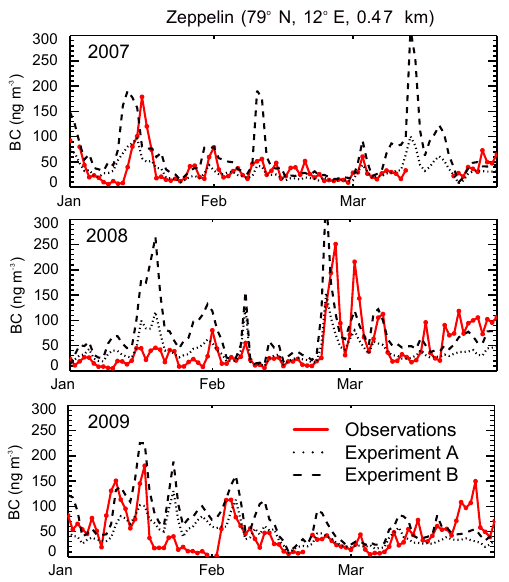
Figure 4. Observed (red solid) and GEOS-Chem simulated (dotted – Exp. A, dashed – Exp. B; see Table 2 and text for details) daily BC concentrations in air (ngm − 3 ) at Zeppelin from January to March in